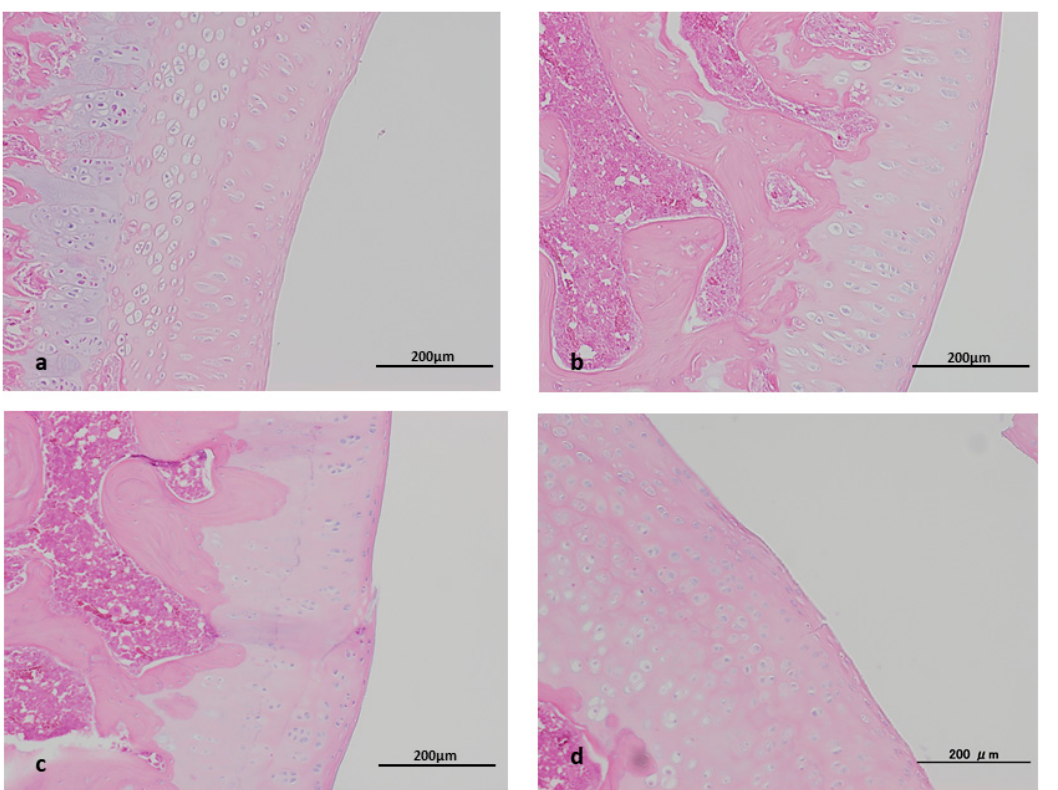
Figure 2. Histopathological study. ( a ) control group, ( b ) Saline group, ( c ) MIA+/MSC − group, ( d ) MIA+/MSC+ group. Control group and Saline group: Cartilage tissue is intact. MIA+/MSC − group: Although the cartilage tissue is preserved on the whole, the cartilage tissue surface layer shows partial injury. MIA+/MSC+ group: Although not as clearly as C, the cartilage tissue surface layer shows partial injury.